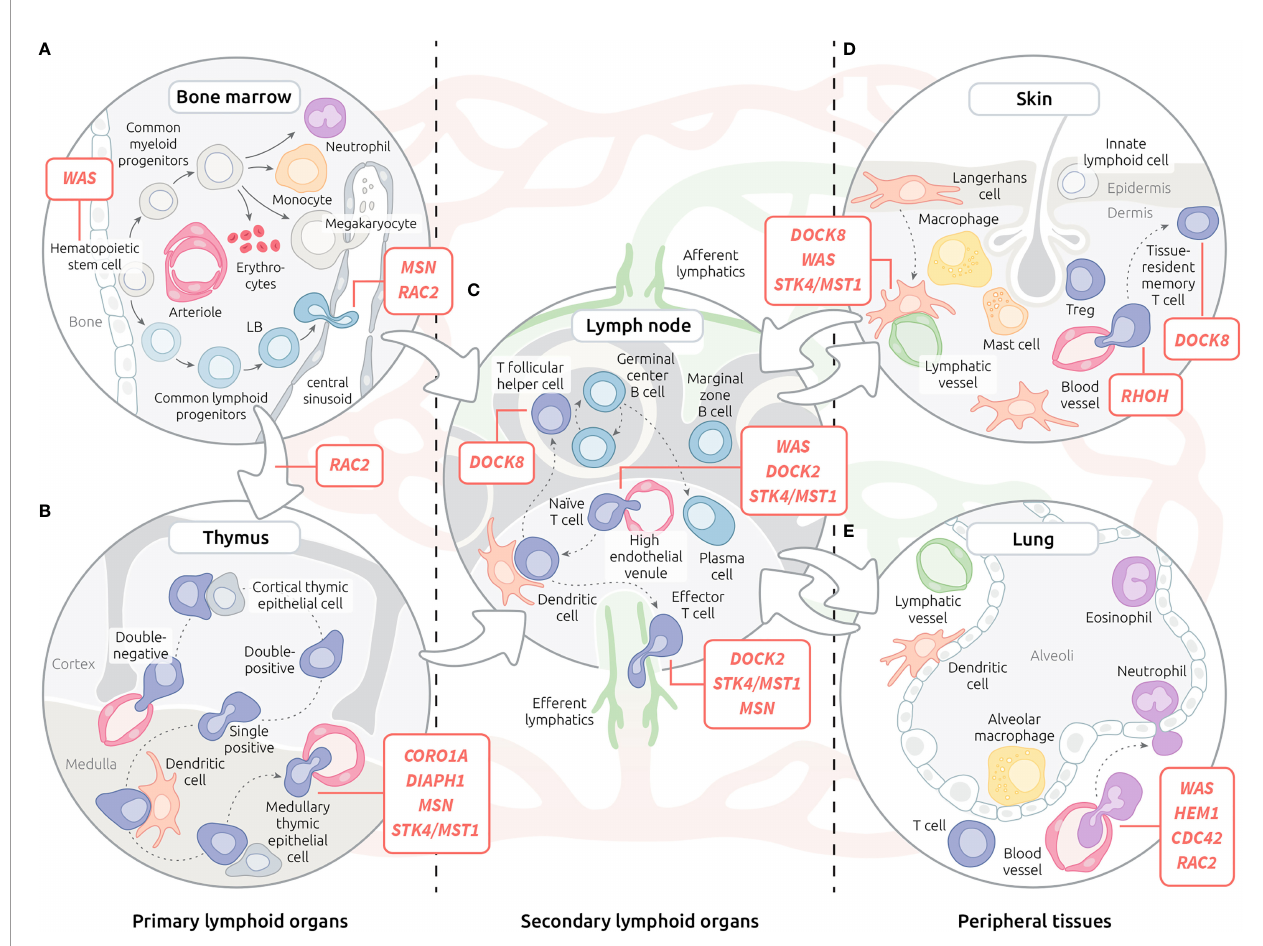
FIGURE 1 | Motility defects in actinopathies at the organism level. (A) Leukocyte traf fi cking in the bone marrow. (B) T lymphocyte traf fi cking in the thymus. (C) Recirculation of leukocytes through blood, lymphatic system and lymph nodes. (D) Migration of leukocytes within the skin. (E) Migration of leukocytes within the lungs. Red lines indicate steps of leukocyte traf fi cking affected by actinopathies with affected genes displayed in corresponding bubble. Lymphatic vessels are depicted in green, while red vessels are depicted in